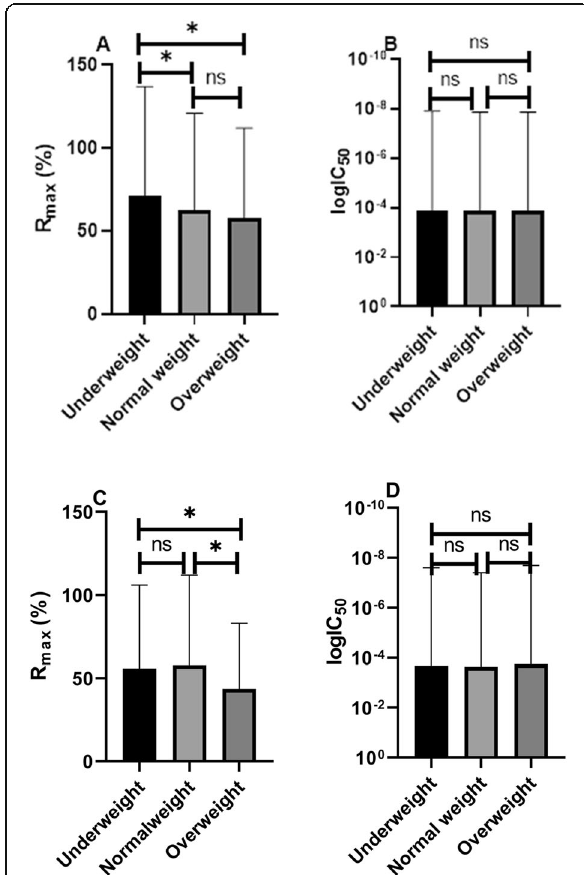
Fig. 4 Relationship of body mass index with ACh activity ( a and b ) and sodium nitroprusside (SNP) ( c and d ) on isolated aortic rat rings. a and c show R max , and graphs b and d show logIC 50 means and SEM, with the asterisk implying significant differences between the two treatments ( P < 0.05) and ns standing